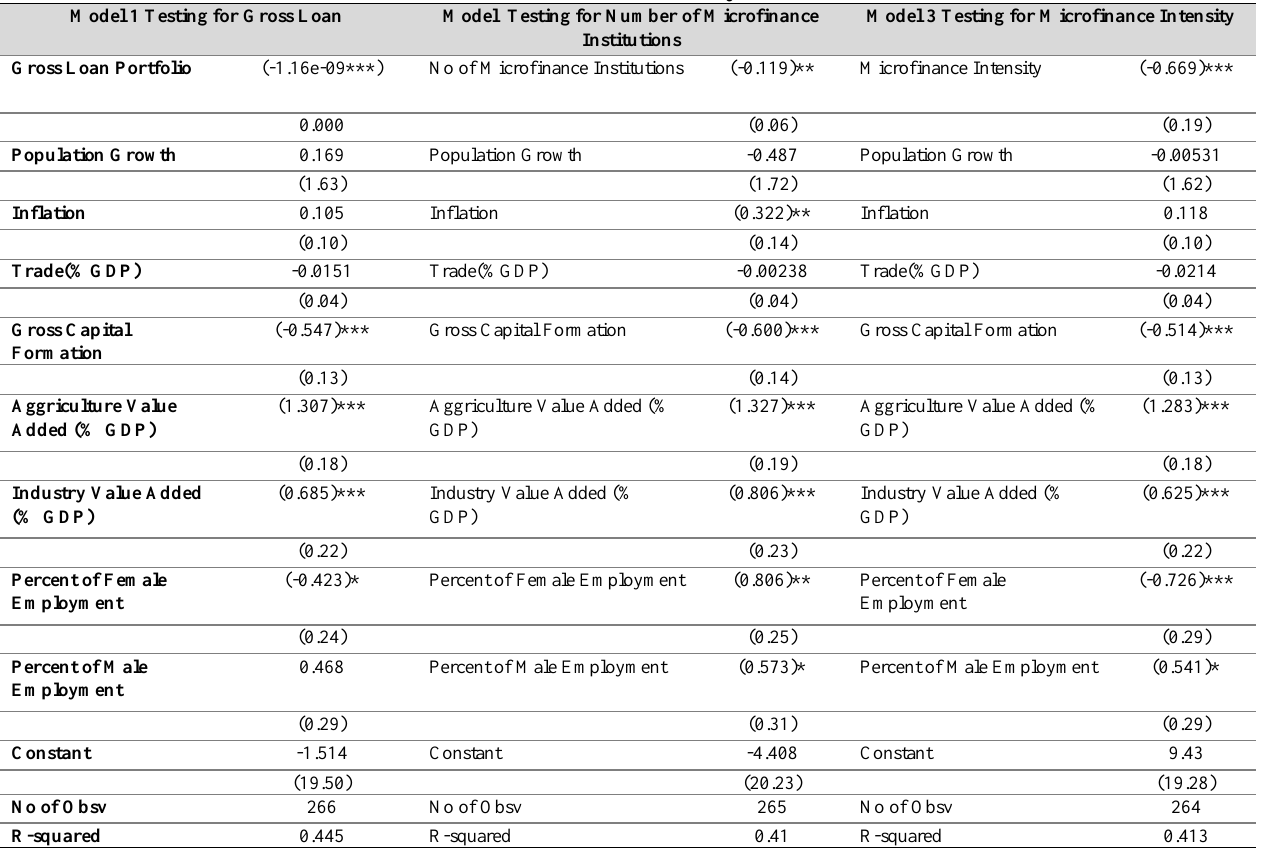
Estimated results of the Model at Poverty headcount ratio $